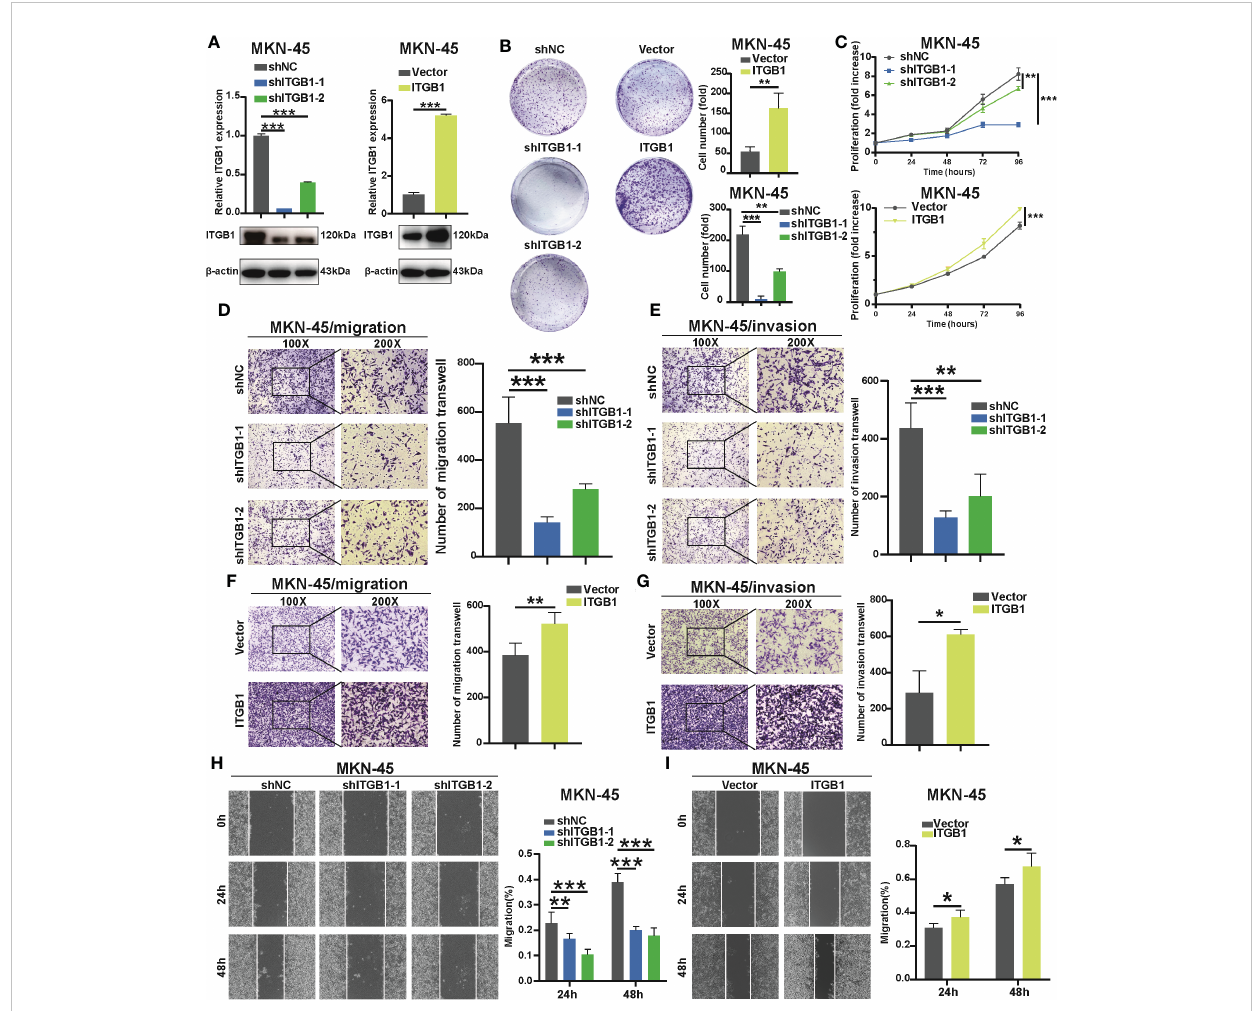
FIGURE 2 Effect of ITGB1 knockdown or forced ITGB1 expression in DGC cells (A) Con fi rmation of knockdown or forced expression of ITGB1 in MKN-45 cells by Quantitative-PCR (q-PCR) combined with Western blotting analysis. Cell proliferation assay in MKN-45 cells with shNC (negative control), shITGB1-1, shITGB1-2 (ITGB1 knockdown), Vector (vector control), or ITGB1 (ITGB1 overexpression) by colony formation (B) and cell counting kit-8 (CCK8) assays (C) . Cell migration (D) and invasion (E) assays in MKN-45 cells with shNC (negative control), shITGB1-1, shITGB1-2 (ITGB1 knockdown). Cell migration (F) and invasion (G) assays in MKN-45 cells with Vector (vector control), or ITGB1 (ITGB1 overexpression). (H) and (I) Cell migartion assay in MKN-45 cells with shNC (negative control), shITGB1-1, shITGB1-2 (ITGB1 knockdown), Vector (vector control), or ITGB1 (ITGB1 overexpression). *, P<0.05; **, P<0.01; ***,